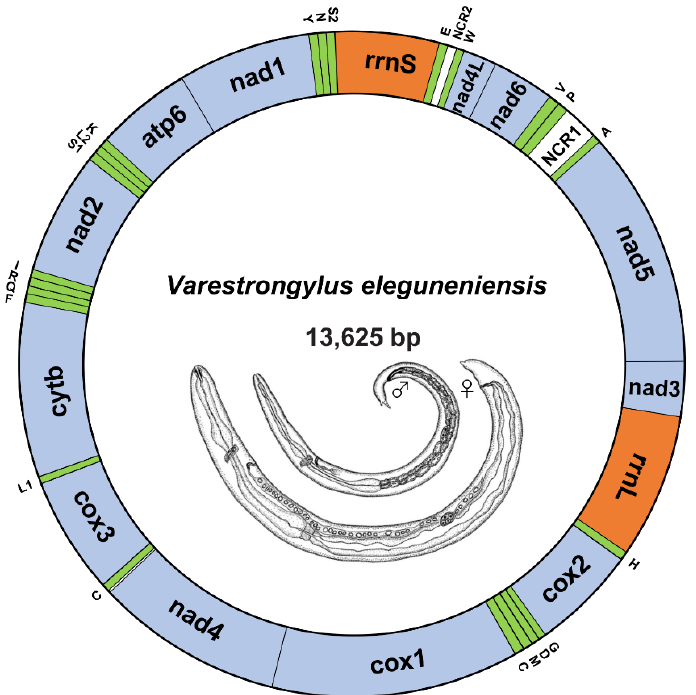
Figure 1. The circular map of V. eleguneniensis mtDNA. Genes are represented by different colored blocks. PCGs are denoted in blue, rRNAs in orange, tRNAs in green and non-coding regions in white. Gene abbreviations: atp6 , ATP synthase subunits 6; cox1-3 , cytochrome oxidase subunits 1-3; cytb , cytochrome b; nad1-6 / nad4L , NADH dehydrogenase subunits 1-6/4 L; rrnL , large rRNA subunit; rrnS , small rRNA subunits; NCR1, AT-rich region; NCR2, the non-coding region. The tRNAs are indicated with their one-letter corresponding amino acids. Line drawings of V. eleguneniensis is adapted with permission from Ref. [13]. 2014, Guilherme G. Verocai.